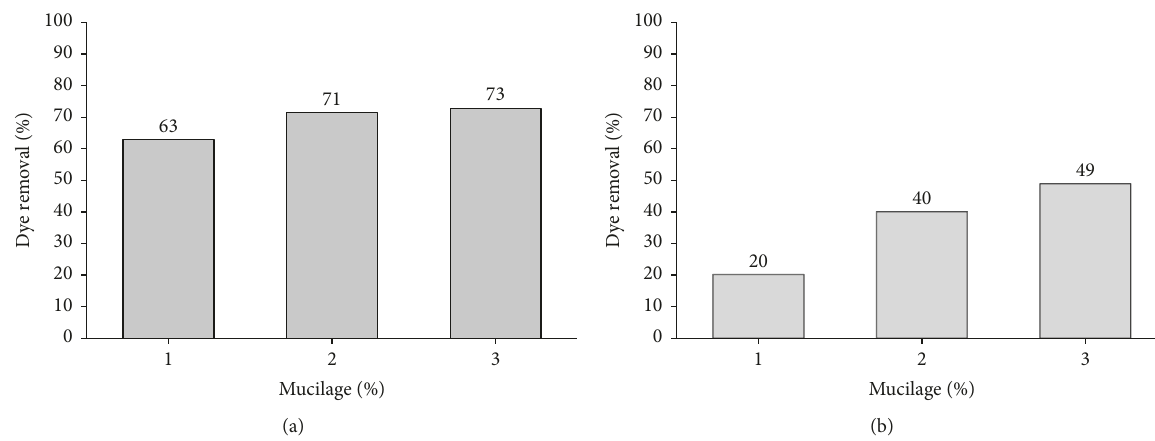
Figure 4: Removal of textile dyes at different concentrations of mucilage: (a) green dye and (b) blue